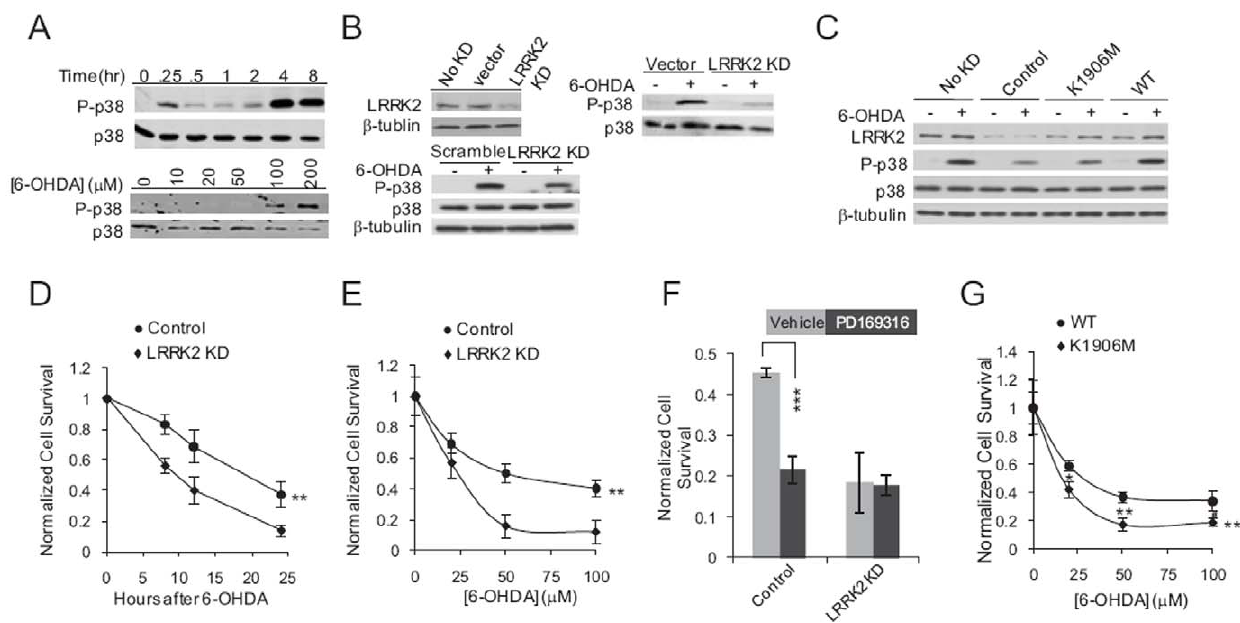
Figure 2. LRRK2 signaling potentiates cell survival after 6-OHDA exposure. ( A ) 6-OHDA induces two peaks of p38 phosphorylation and the later peak is 6-OHDA dose-dependent. Western blotting with antibodies against phosphorylated p38 (P-p38) and total p38. Lysates were prepared from SH-SY5Y cells treated with 100 m M 6-OHDA for the indicated times (upper panel) or with the indicated concentrations of 6-OHDA for 4 hours (lower panel). ( B ) 6-OHDA-induced p38 activation is dependent on LRRK2 function. Upper left panel: Western blot analysis of LRRK2 and b -tubulin (loading control) levels in parental SH-SY5Y cells (No KD), SH-SY5Y cells transfected with a control vector (vector), and SH-SY5Y cells from a MIX LRRK2 KD line (LRRK2 KD). Upper right panel: Western blot analysis of P-p38 and total p38 levels in SH-SY5Y cells transfected with a control vector (vector) or SH-SY5Y cells from a MIX LRRK2 KD line (LRRK2 KD) with or without exposure to 100 m M 6-OHDA for 4 hours. Lower panel: Western blot analysis of P- p38 and total p38 levels in SH-SY5Y cells transfected with a scramble shRNA (Scramble) or MIX LRRK2 shRNA (LRRK2 KD) with or without exposure to 100 m M 6-OHDA for 4 hours. ( C ) Expression of WT, but not K1906M mutant, LRRK2 restores 6-OHDA-induced p38 activation in LRRK2 KD cells. Western blot analyses of LRRK2, P-p38 and total p38 levels. Lysates were prepared from parental SH-SY5Y cells reconstituted with control vector (No KD)or 3 9 -UTR LRRK2 KD SH-SY5Y cells reconstituted with control vector (Control), K1906M or WT LRRK2 with or without exposure to 100 m M 6-OHDA for 4 hours. ( D ) Cells from a MIX LRRK2 KD SH-SY5Y line (LRRK2 KD, diamonds) and SH-SY5Y cells transfected with a control vector (Control, circles) were treated with 100 m M 6-OHDA for the indicated times. Cell viability was determined using an XTT-based calorimetric assay. Data represent the mean 6 SEM of 3 independent experiments. **, p , 0.01 by two-way ANOVA. ( E ) Cells with reduced LRRK2 expression show heightened sensitivity to 6-OHDA. Cells from a MIX LRRK2 KD SH-SY5Y line (LRRK2 KD, diamonds) and SH-SY5Y cells transfected with a control vector (Control, circles) were treated with the indicated concentrations of 6-OHDA for 24 hours. Cell viability was determined using an XTT-based calorimetric assay. Data represent the mean 6 SEM of 3 (LRRK2 KD) or 4 (control) independent experiments. **, p , 0.01 by two-way ANOVA. ( F ) Inhibition of p38 potentiates 6-OHDA-induced cell death in cells expressing LRRK2. SH-SY5Y cells transfected with control vector (Control) and MIX LRRK2 KD SH-SY5Y cells (LRRK2 KD) were treated with 100 m M 6-OHDA and either control vehicle or PD169316 for 24 hours. Cell survival was measured with a XTT-based calorimetric assay. Data represent the mean 6 SEM of 4 independent experiments. ***, p , 0.005 by t-test. ( G ) Expression of WT, but not kinase-inactive mutant, LRRK2 counteracts 6-OHDA-induced cell death. 3 9 -UTR LRRK2 KD SH-SY5Y cells reconstituted with K1906M mutant LRRK2 (diamonds) or WT LRRK2 (circles) were exposed to the indicated concentrations of 6-OHDA for 24 hours and cell survival was assessed with a XTT-based calorimetric assay. Data represent the mean 6 SEM of 4 independent experiments. **, p , 0.01 by two-way ANOVA, and *, P , 0.05; **, P , 0.01 by t-test.